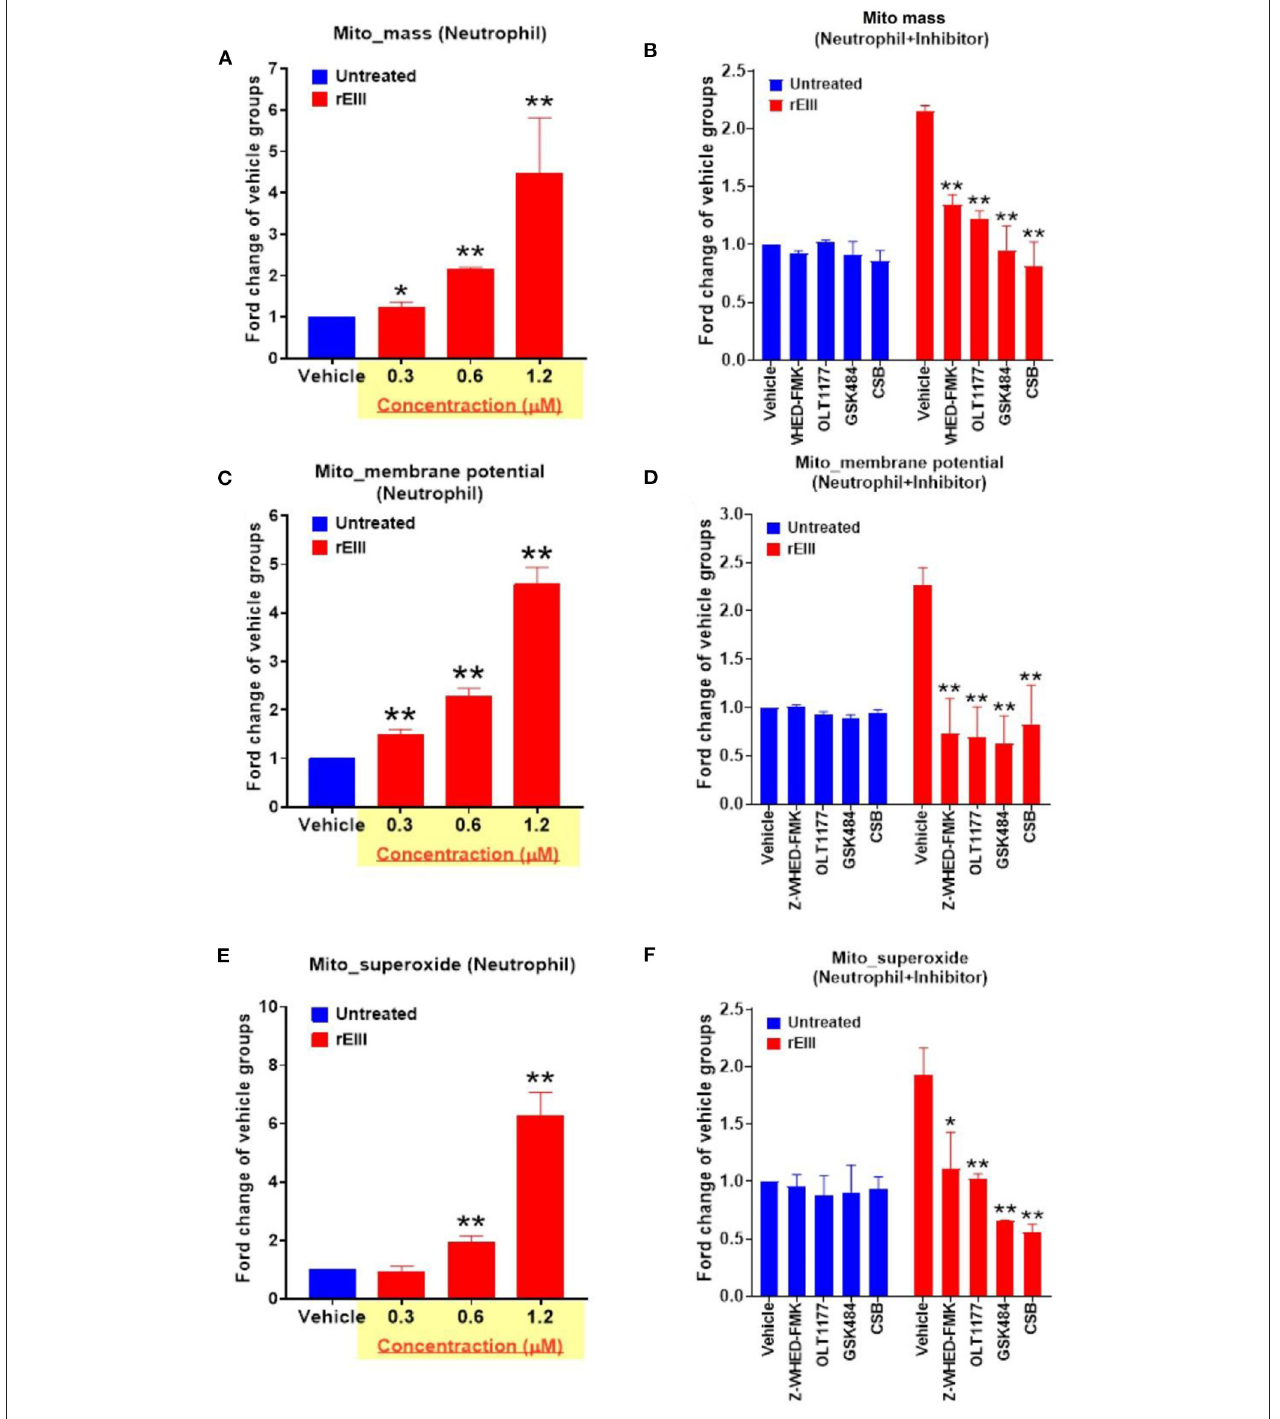
FIGURE 5 | DENV rEIII-induced mitochondria ROS production is ameliorated by Nlrp3 inflammasome and NETosis inhibitor. The rEIII (0.6 µ M)-induced (1h) elevations of neutrophil mitochondria mass (A) membrane potential (C) and superoxide (E) levels in a dose dependent manner. The induction of these mitochondria metabolic burdens in the neutrophils could be suppressed by treatments of Nlrp3 and caspase 1 inhibitors Z-WHED-FMK (10 µ M) and OLT1177 (10 µ M), NETosis inhibitor GSK484 (10 µ M), and the cell-binding competitive inhibitor chondroitin sulfate B (CSB, 10 µ g/mL), respectively (B,D,F) . n = 6, * P < 0.05, ** P < 0.01, vs. respective untreated vehicle groups (A,C,E) ; * P < 0.05, ** P < 0.01, vs. respective vehicle groups (B,D,F) .